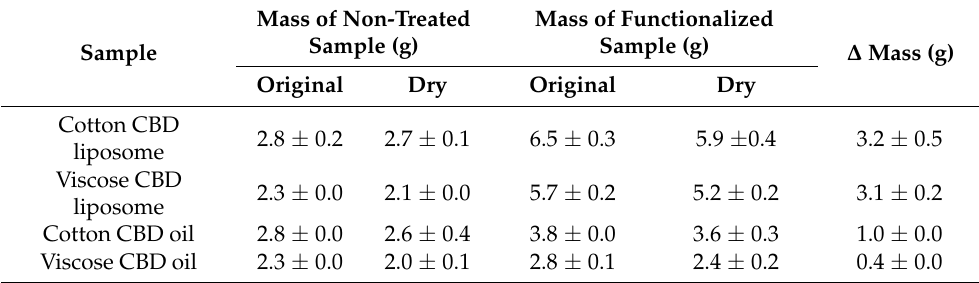
Table 3. Mass of original (non-dried) and dry mass of cotton and viscose tampon samples before and after functionalization with CBD liposome liquid formulation and CBD oil.